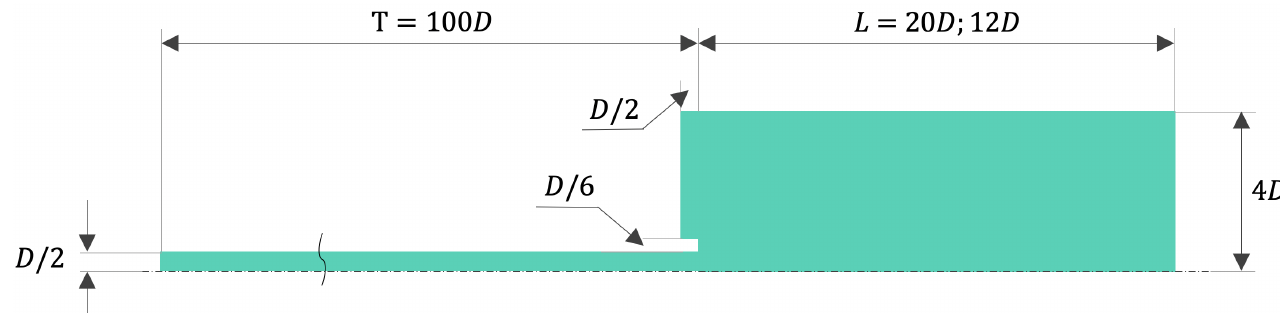
Figure 1. Slice of the 5 degree wedge simulation domain. D is the diameter of the nozzle, T is the length of the nozzle, and L is equal to 20D for Hardalupas et al. [1] test case and 12D for Bogusławski and Popiel [27] test